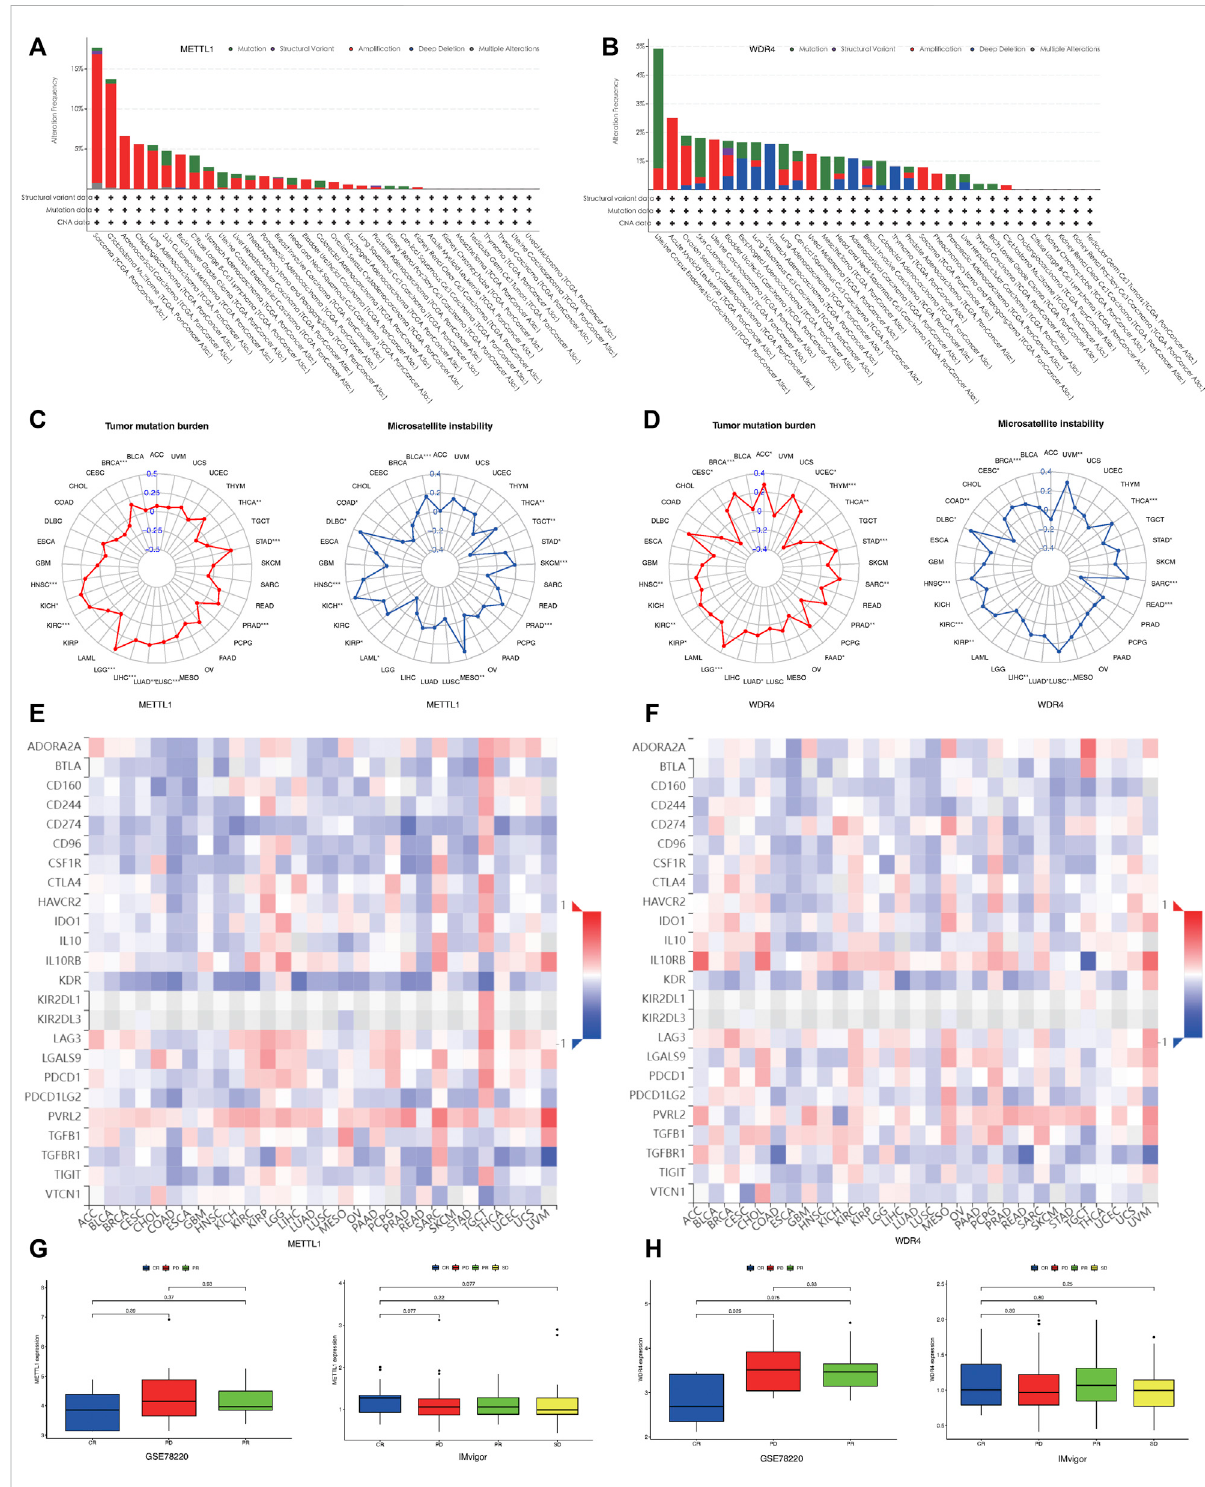
FIGURE 6 Mutational landscape of METTL1 and WDR4 in cancer. (A) METTL1 mutation frequency in multiple TCGA pan-cancer studies according to the cBioPortal database. (B) WDR4 mutation frequency in several TCGA pan-cancer studies according to the cBioPortal database. (C) Radar plot visualizing the relationship between METTL1 expression and TMB. Radar plot visualizing the relationship between WDR4 expression and TMB. (D) Radar plot visualizing the relationship between METTL1 expression and MSI. Radar chart visualizing the relationship between WDR4 expression and MSI. (E) The relationship between METTL1 expression and immunoinhibitors in pan-cancer. (F) The relationship between WDR4 expression and immunoinhibitorsinpan-cancer. (G) TheexpressionlevelsofMETTL1weresigni fi cantlydifferentinfourgroupsofIMvigorratherthanGSE78220. (H) The expression levels of WDR4 were signi fi cantly different in three groups of GSE78220 rather than